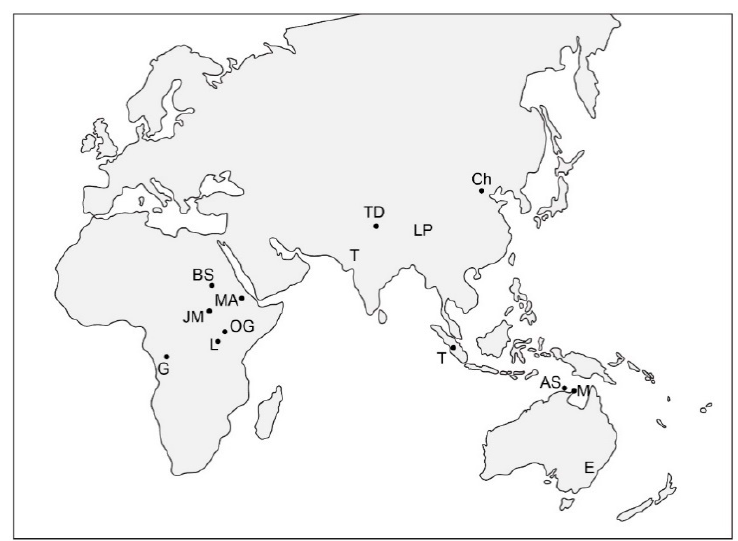
Figure 1. Location maps showing places cited in the text. From west to east in Africa, places are as follows: G is Gombe prehistoric site; JM is Jebel Marra volcano; BS is Bir Sahara and Bir Tarfawi; L is Laetoli; OG is Olduvai Gorge; MA is Middle Awash Valley, Afar Rift and Gona prehistoric site. From west to east in Asia, T is Thar Desert, India; TD is Taklimakan Desert, China; LP is Loess Plateau, China; T is Toba volcano, Sumatra; and Ch is Choukoutien prehistoric site, near Beijing, China. In Australia, AS is Arafura Sea, M is Millingimbi, and E is Eastern Highlands including the headwaters of the Lachlan River.